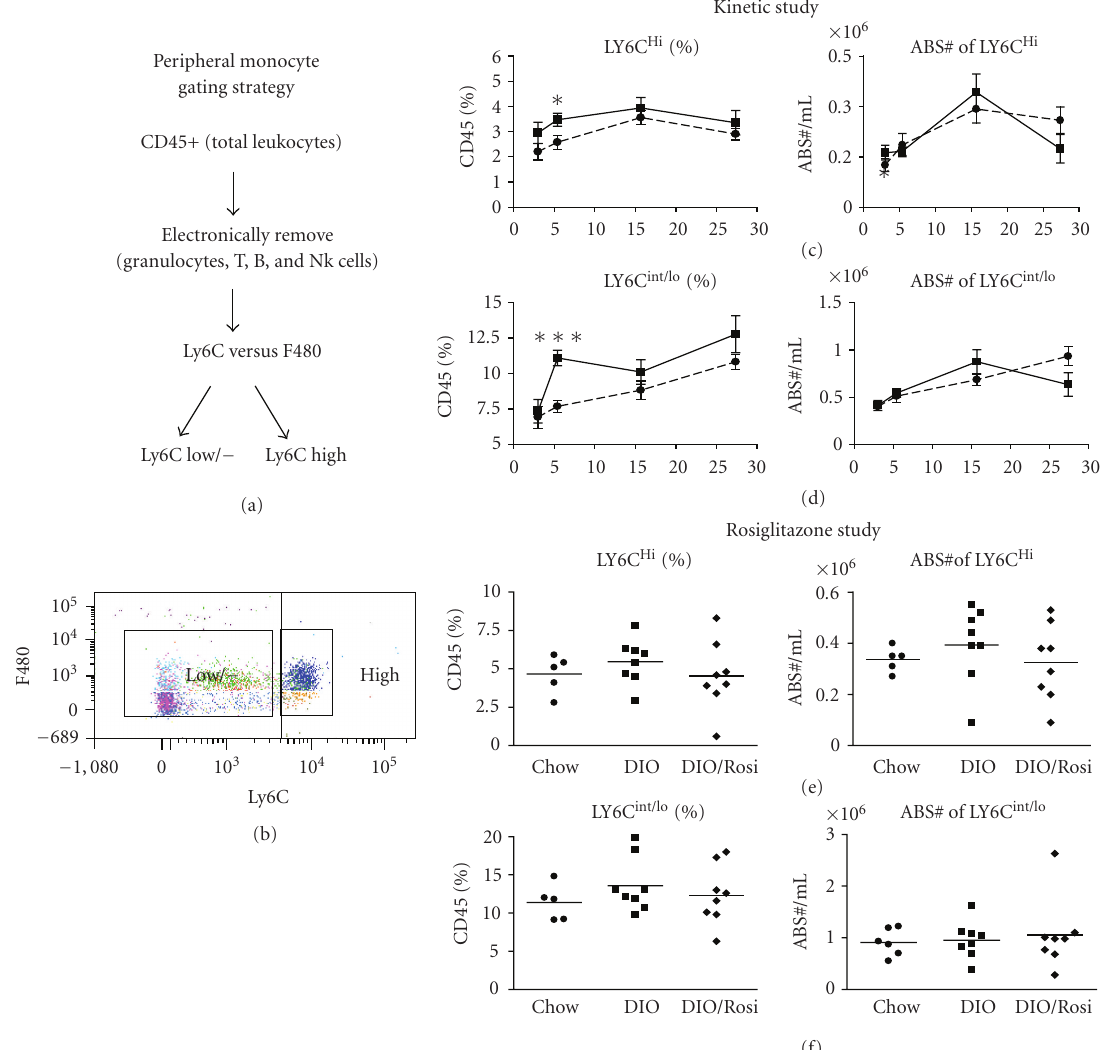
Figure 7: Rosiglitazone can modulate a trend for an elevation in the percentage of monocytes. Whole blood was stained and monocytes were assessed in the kinetic timecourse at 3, 6, 16, and 27-weeks, as well as in the Rosiglitazone study terminated at 18 weeks. (a) and (b) show the gating strategy and a representative dot plot that were employed to identify the monocyte populations. (c)-(d). In the kinetic study, results show a trend for an increase in the percentage of both Ly6Chi and Ly6Clo monocyte populations in the DIO cohort compared to chow, but not in absolute numbers. (e)-(f). Rosiglitazone nonsignificantly reduced the elevation in both the Ly6C high and Ly6Clo monocyte percentages and the Ly6Chi but not Ly6Clo absolute